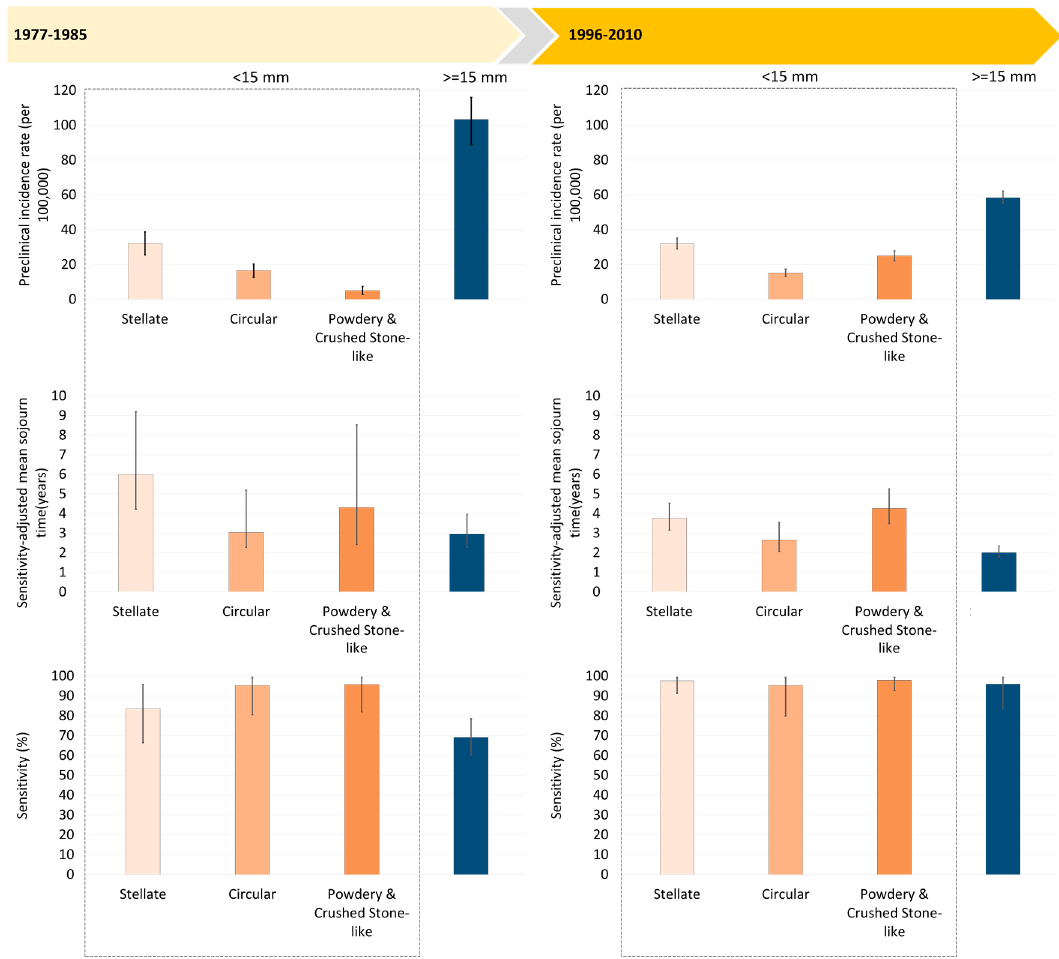
Figure 2. Mammography-featured natural history of breast cancers smaller than 15 mm and breast cancers larger than 15 mm.